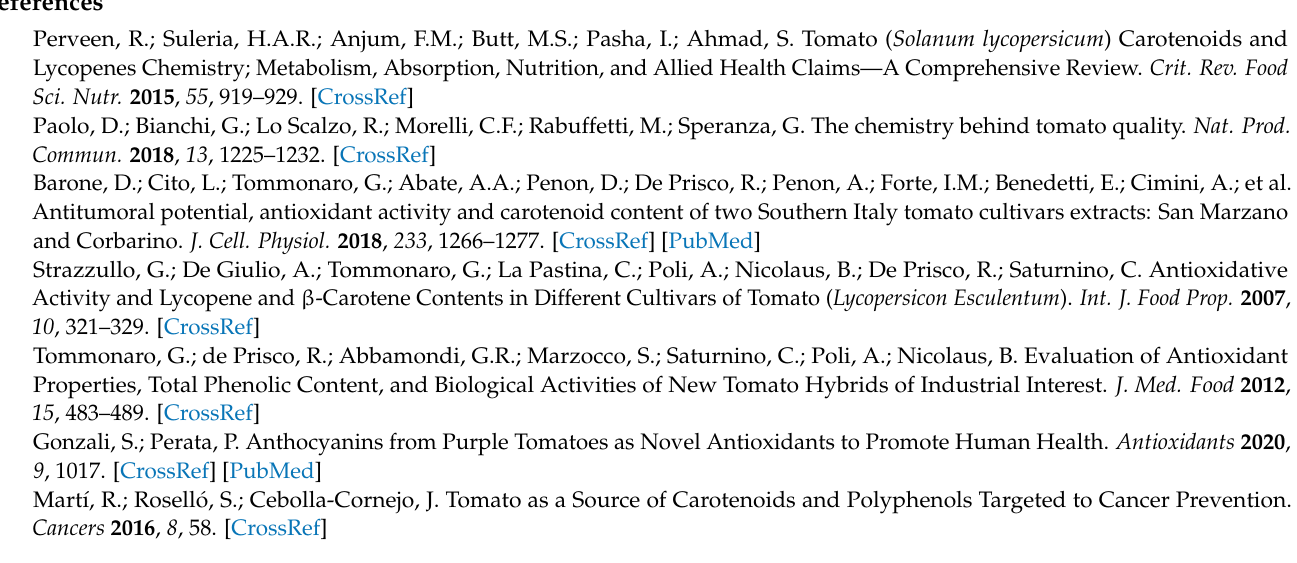
calchone. Figure S2. 1 H, 1 H COSY NMR (CD 3 OD, 600 MHz) of naringenin calchone. Figure S3. 1 H, 13 C-HSQC NMR (CD 1 H, 13 C-HMBC NMR 3 OD, 600 MHz) of naringenin calchone. Figure S4. (CD 3 OD, 600 MHz) of naringenin calchone. Figure S5. Calibration curves for glutamic acid and aspartic acid. Figure S6. Calibration curves for 5 (cid:48) -AMP and 5 (cid:48) -GMP. Figure S7. ESI-MS/MS spectra of isomer ions at m/z 515.1178 putatively identified as dicaffeoyl-quinic acids I-IV. Figure S8. ESI- MS/MS spectrum of the ion at m/z 677.1498 putatively identified as tricaffeoyl-quinic acid. Figure S9. ESI-MS/MS spectra of isomer ions at m/z 341.0868 putatively identified as caffeic acid hexosides I-III. Table S1. Tomato sample weights and yield of methanolic extracts. Table S2. NMR signal assignments for naringenin